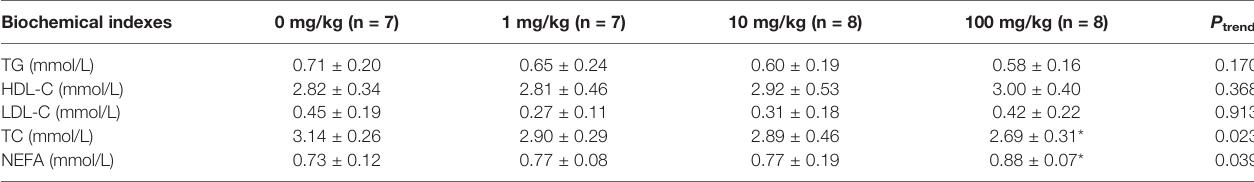
TABLE 1 | Effect of benzene on biochemical indexes. Biochemical